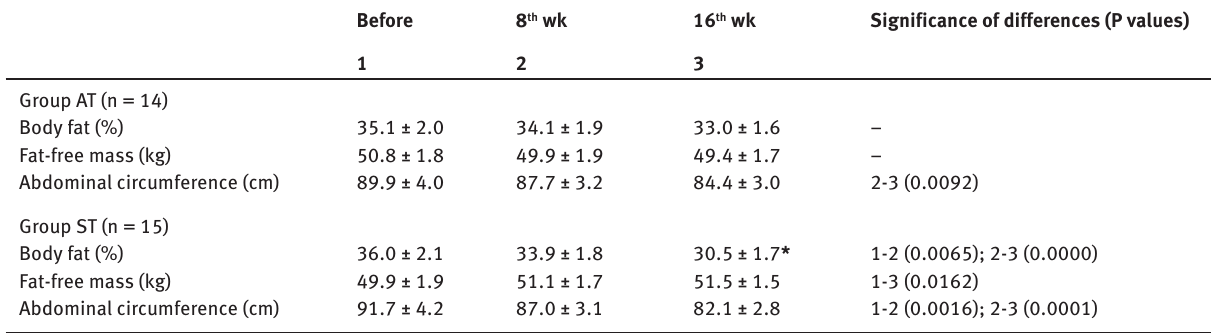
Table 3: Characteristics of overweight females’ body fat before and after 8 and 16 wks of aerobic (AT) and strength (ST) training (mean ± SD). Before